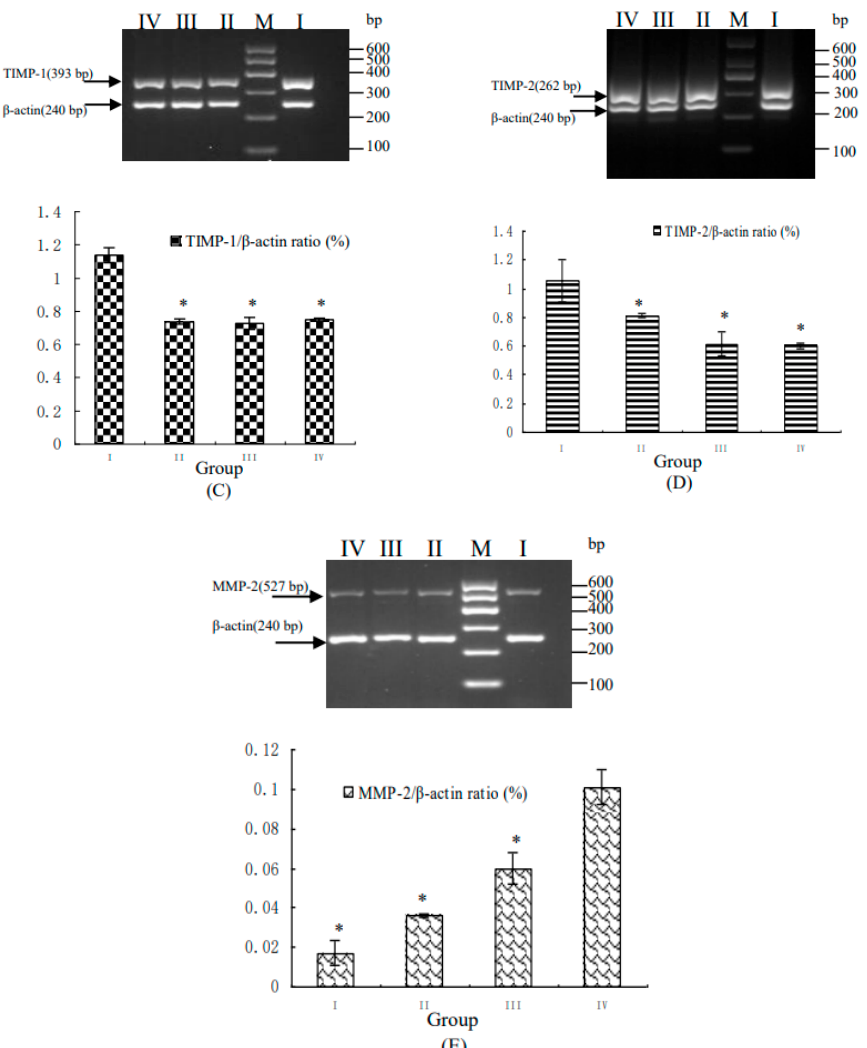
Figure 1. The mRNA expression levels of genes associated with hepatic fibrogenesis in HSC-T6 cells treated with a combination of taurine, EGCG and genistein. Semi-quantitative PCR data are shown for cells treated with a combination of taurine, EGCG and genistein in varying doses. The relative mRNA expression levels of TGF- β 1 ( A ), Col-I ( B ), TIMP-1 ( C ), TIMP-2 ( D ), and MMP-2 ( E ) are presented; the upper panels show representative pictures of agarose gels and the lower panels show relative quantification of mRNA expression levels in (I) untreated control cells, or cells treated with (II) 0.015 mg/mL taurine, 0.0175 mg/mL EGCG and 0.0035 mg/mL genistein, (III) 0.03 mg/mL taurine, 0.035 mg/mL EGCG and 0.007 mg/mL genistein, or (IV) 0.06 mg/mL taurine, 0.07 mg/mL EGCG and 0.014 mg/mL genistein. (M) Marker. Data are presented as the mean ± S.E.; * p < 0.05 vs. group I (untreated control).